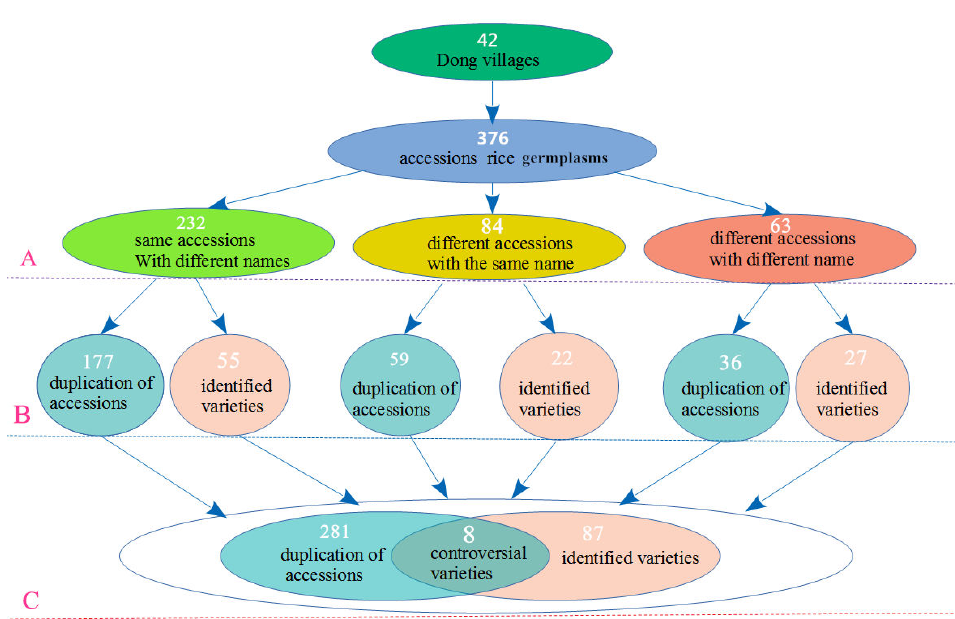
Figure 1. Kam fragrant glutinous rice varieties identified by folk classification at three levels. ( A ) The varieties planted by the ordinary farmers were identified. ( B ) The village varieties were identified by the elders, the patriarch, or the leader of a village. ( C ) Representatives composed of elders, patriarchs, and village leaders from 13 villages with large populations and a variety of resources were selected to compare and identify all the germplasm. Finally, those germplasms with different names but of the same variety were merged, different varieties with the same names were separated, 281 were identified as duplicate varieties, and 95 Kam fragrant glutinous rice varieties were identified, including 8 controversial